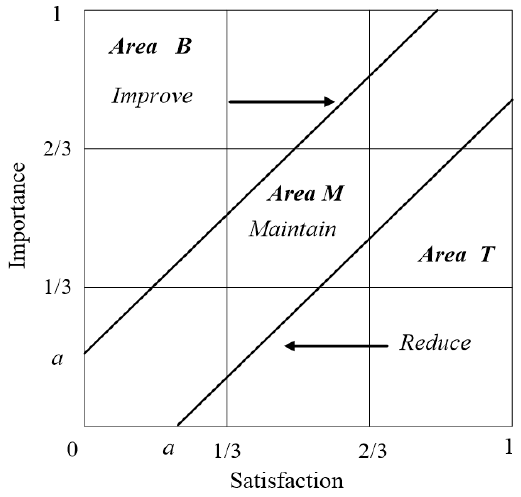
Figure 1. Performance evaluation matrix.